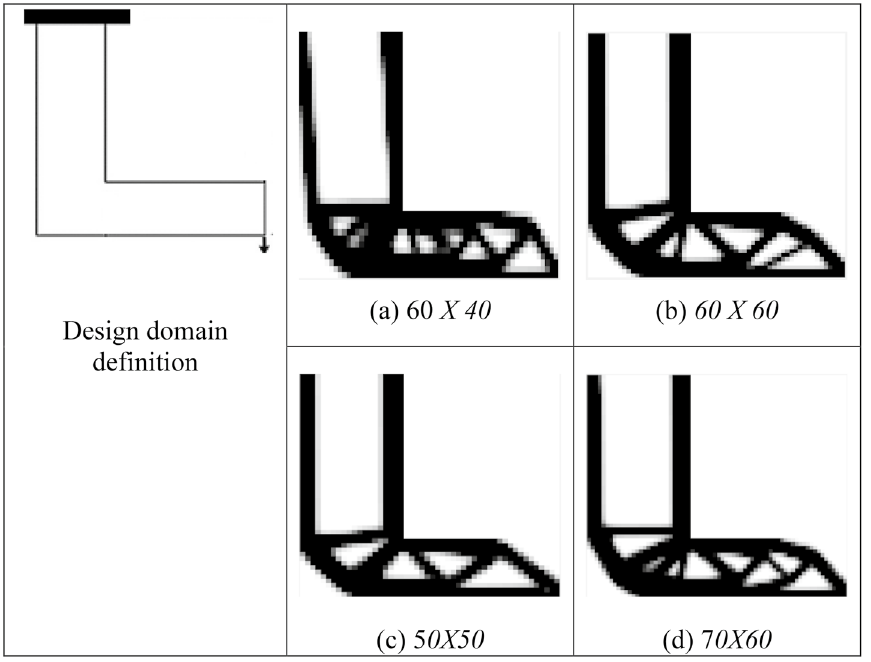
Table 1 Boundary and loading condition with respective topologies under various discretization size L-shape variant